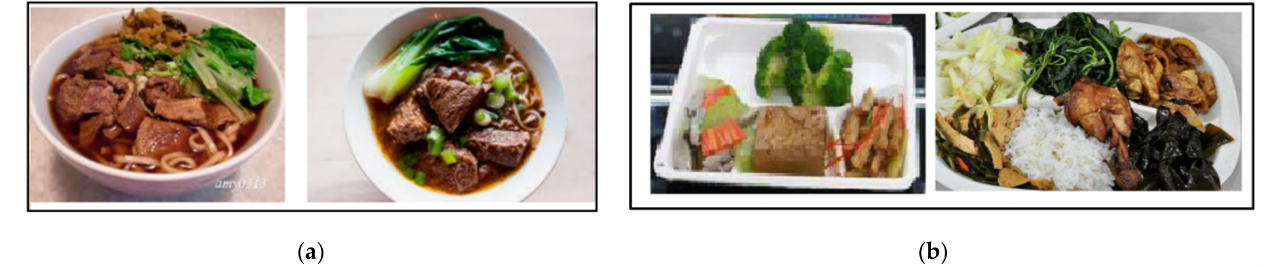
Figure 3. Two different categories of food—( a ) single dish, beef noodle and ( b ) mixed food,